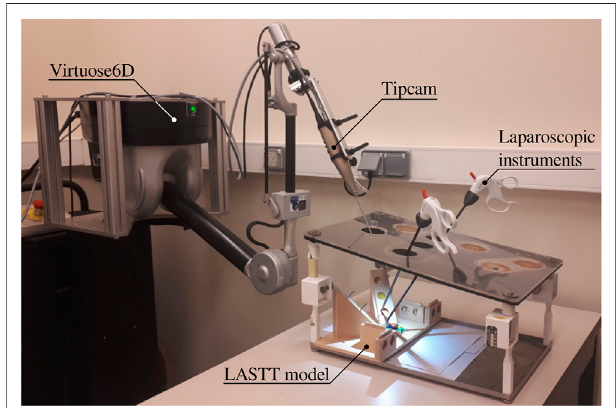
FIGURE 1 | Proposed experimental setup for autonomous endoscope control in a laparoscopic setting. The LASTT model (European Academy of Gynaecological Surgery, 2020) showcased within the box trainer is designed for the simulation ofsimplesurgicaltasks with a focuson gynaecological procedures. It is common ground for the practice and evaluation of hand-eye and bi-manual coordination skills.